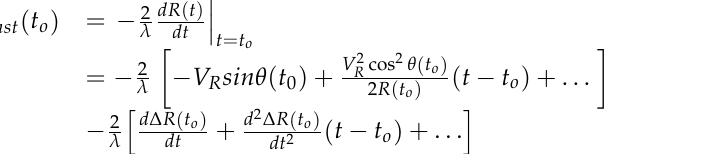
Figure 1. Simplified two-dimensional ISAR geometry.